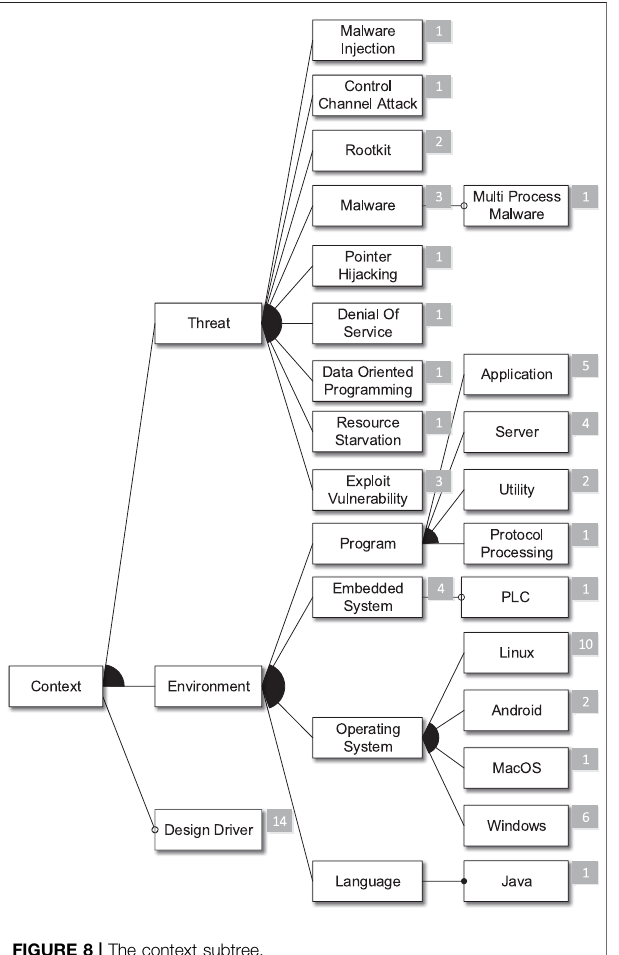
FIGURE 8 | The context subtree.